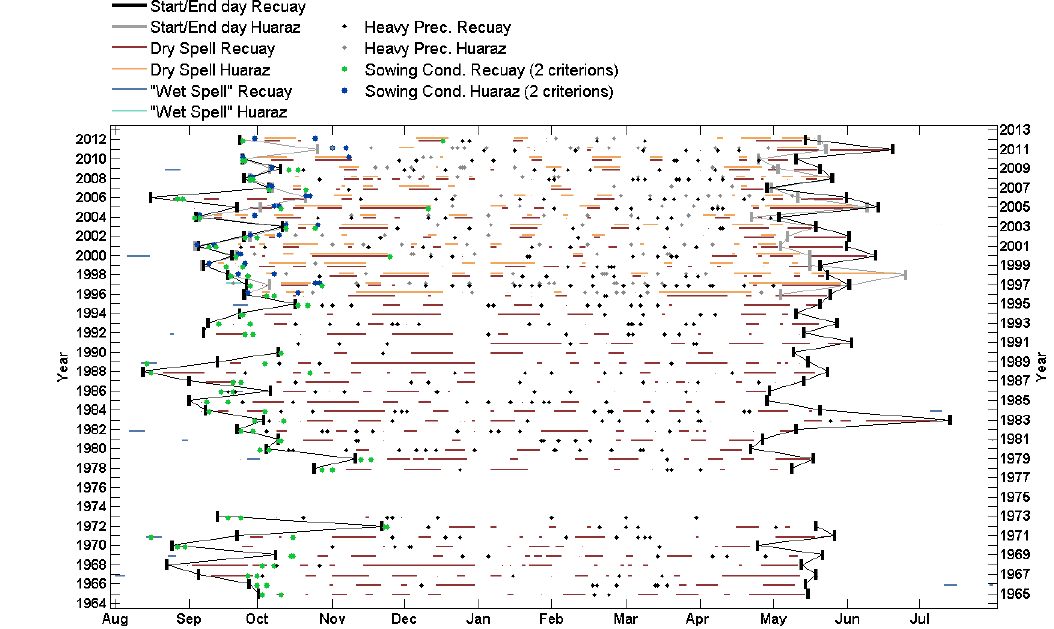
Figure 3. Precipitation features derived from daily precipitation sums based on measurements in Recuay (1964 to 2013 with gaps) and Huaraz (1996 to 2013), with the criteria described in Sect. 3.3. The y axes show the calendar year in which each agricultural year (1 August to 31 July)